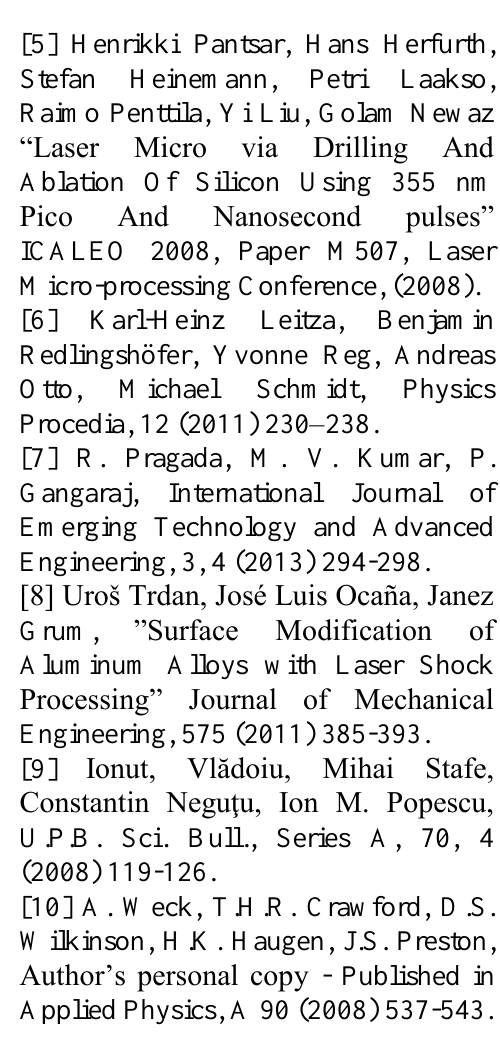
Fig.8: Hole depth increase with laser power density in